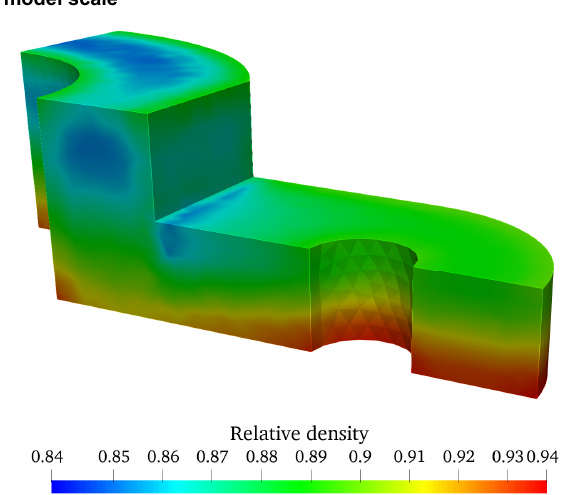
Figure 8. Average relative density error with respect to model scale